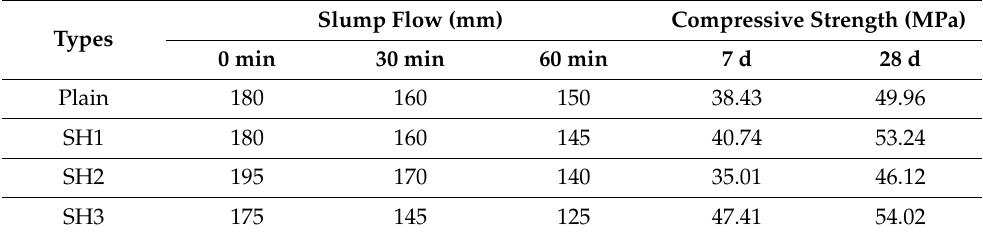
Table 2. Slump flow and compressive strength test results for mortar